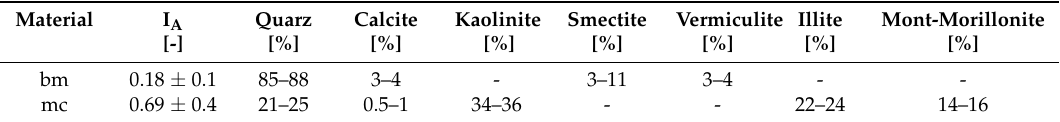
Table 2. Coefficients of activity (I A ) and clay mineralogy of marsh clay (mc) and boulder marl (bm) with n = 3 per material. The symbol ± corresponds to the standard